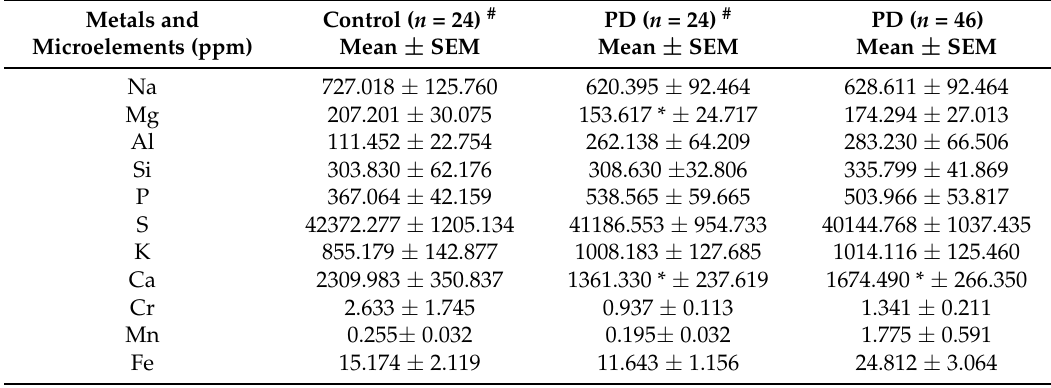
Table 1. Metals and microelements in the hair of Parkinson’s patients and control subjects. Metals